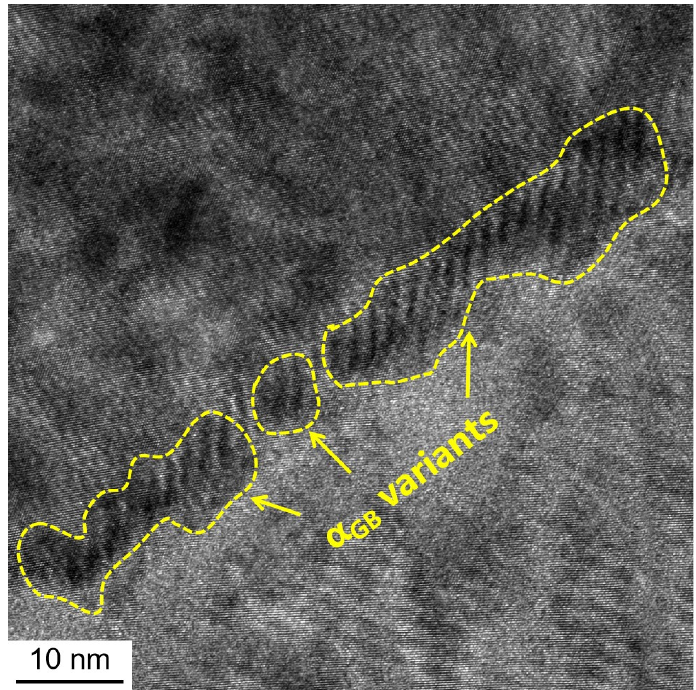
Figure 10. HRTEM image of hot-compressed microstructure at a true strain of 1.2 in the Ti-B12 alloy.